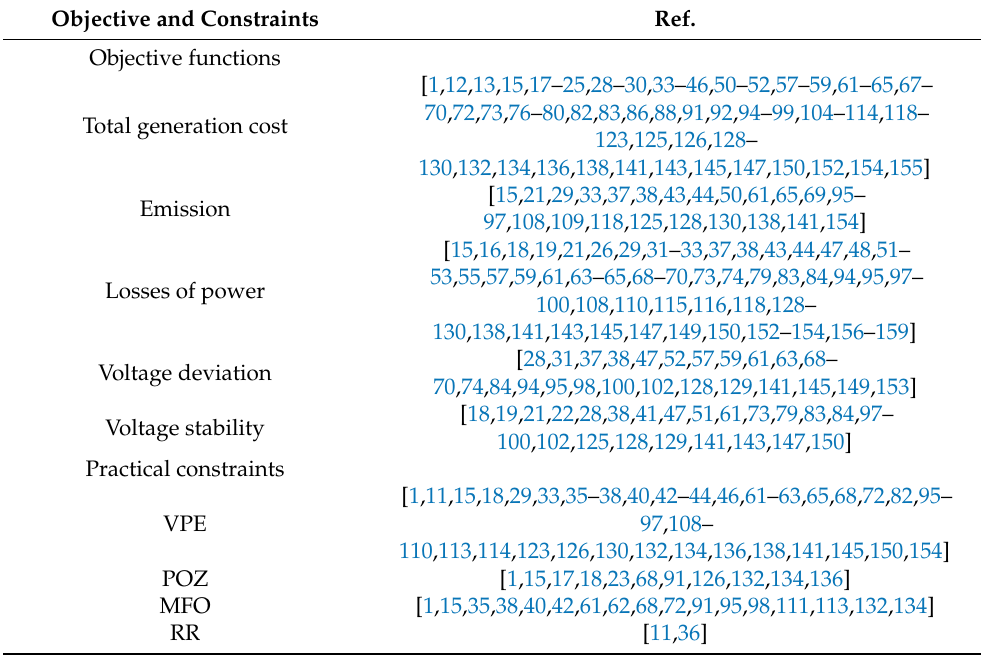
Table 3. Classification of references based on objective functions and practical limitations as well. Objective and Constraints Ref.